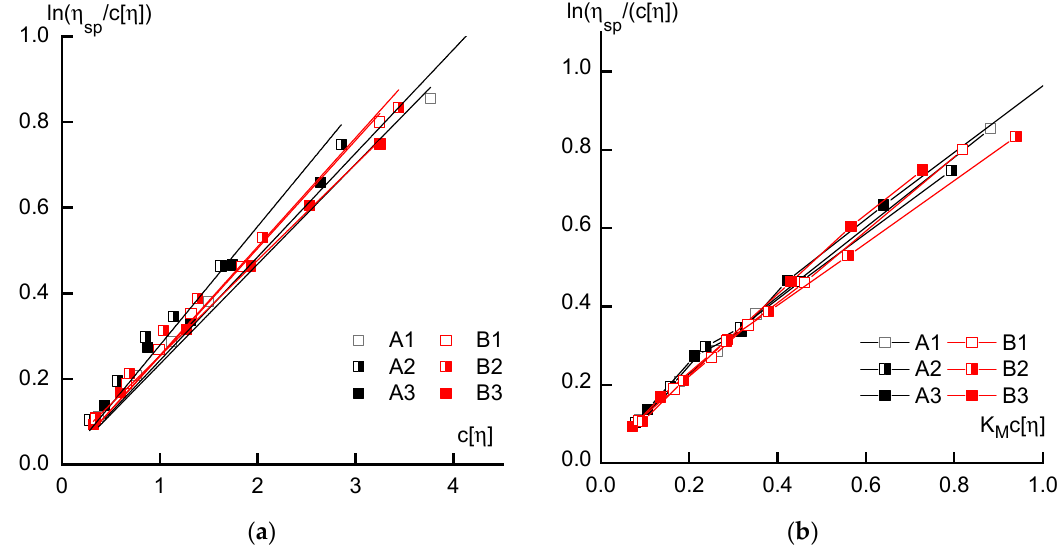
Figure 3. Dependences of reduced viscosity on the volume engaged by macromolecules in the solution ( a ), and the same when using the Martin constant ( b ).